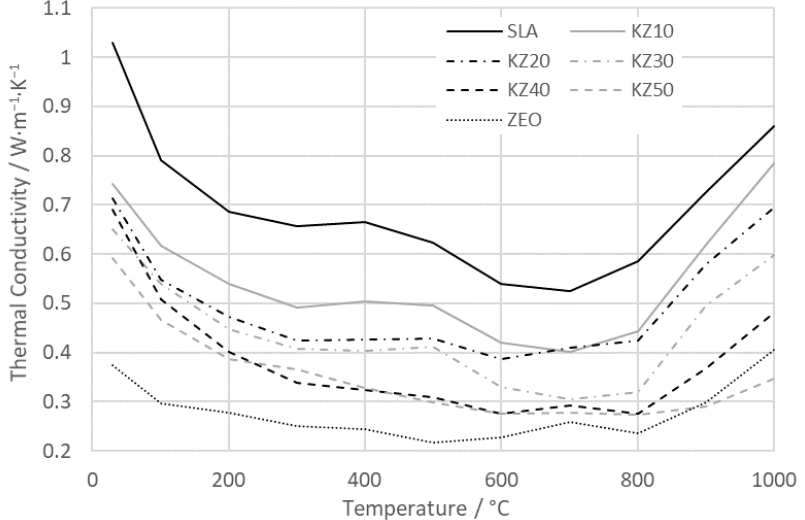
Figure 14. Thermal conductivity of the studied samples.